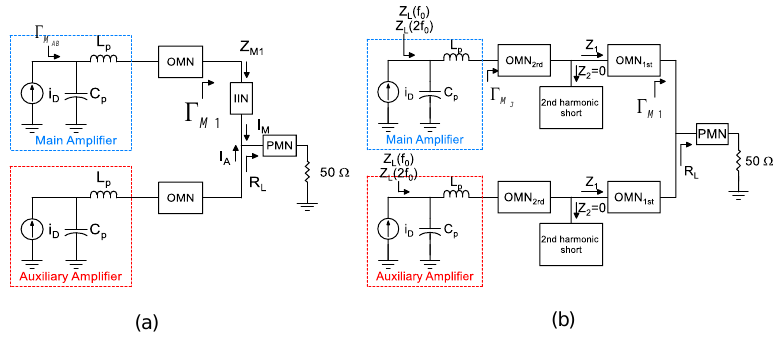
Figure 1. Schematic diagram of the ( a ) conventional DPA. ( b ) Proposed Class-J